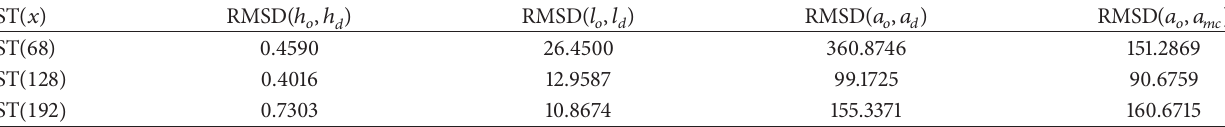
Table 9: RMSD calculated by using observed versus image calculated